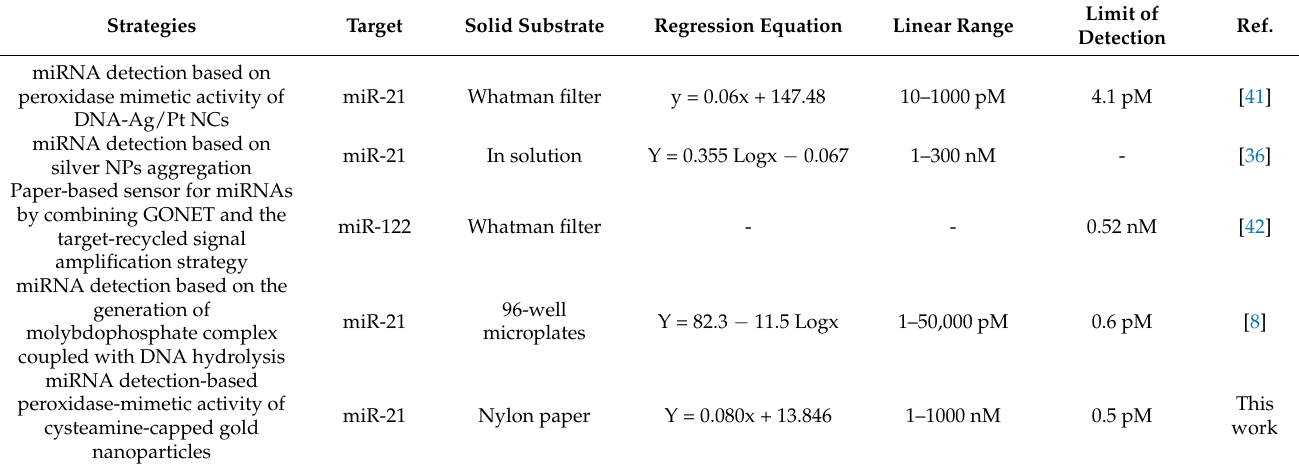
Table 2. Comparative analyses of smartphone-based miRNA detection.